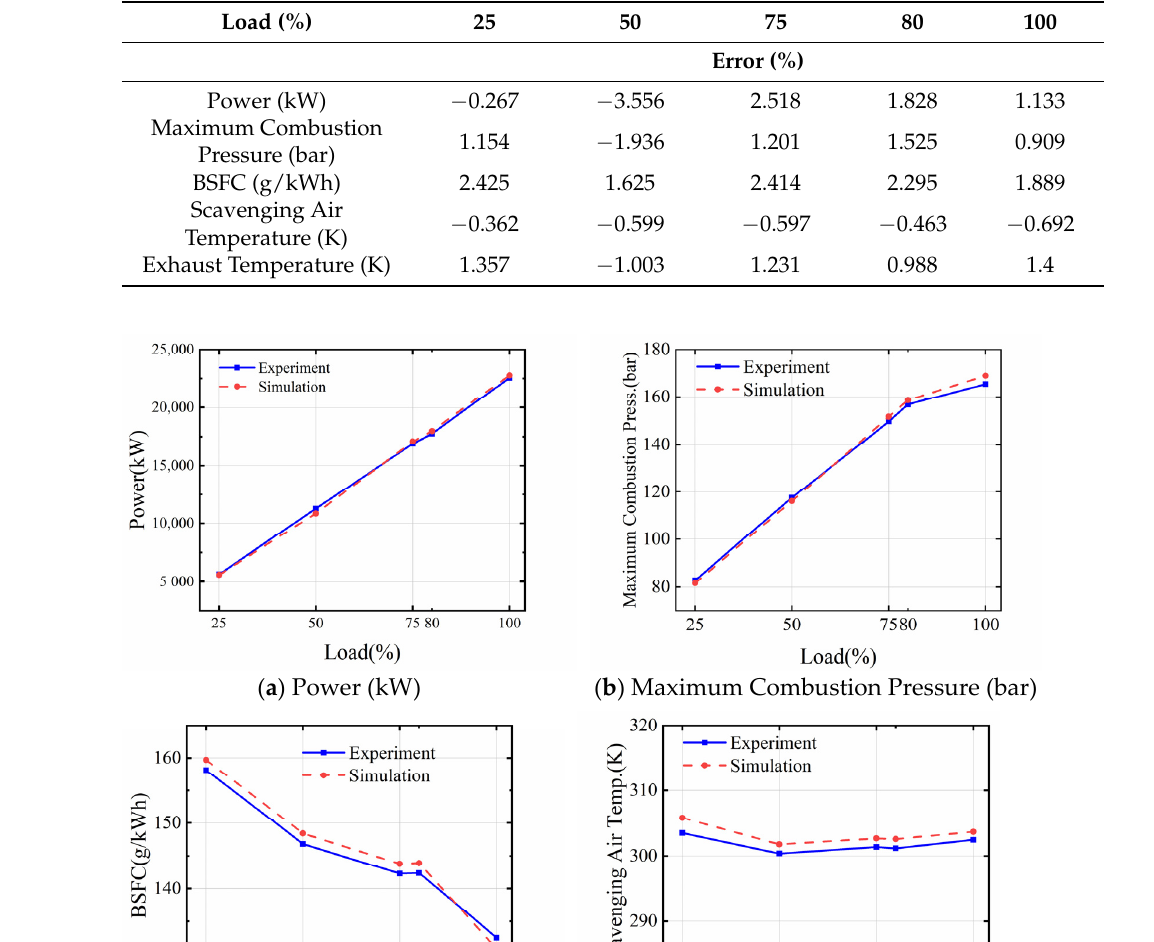
Table 5. Calculation errors of parameters in gas mode.